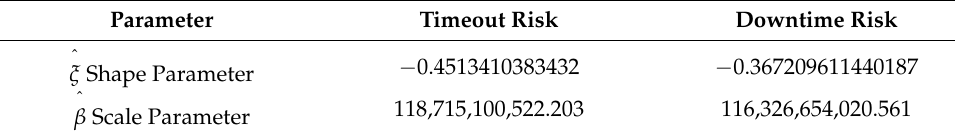
Table 5. GPD parameter